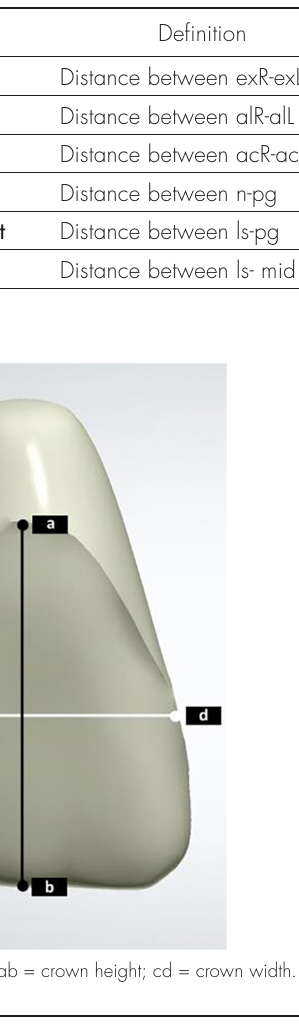
Table III. 3D distances and